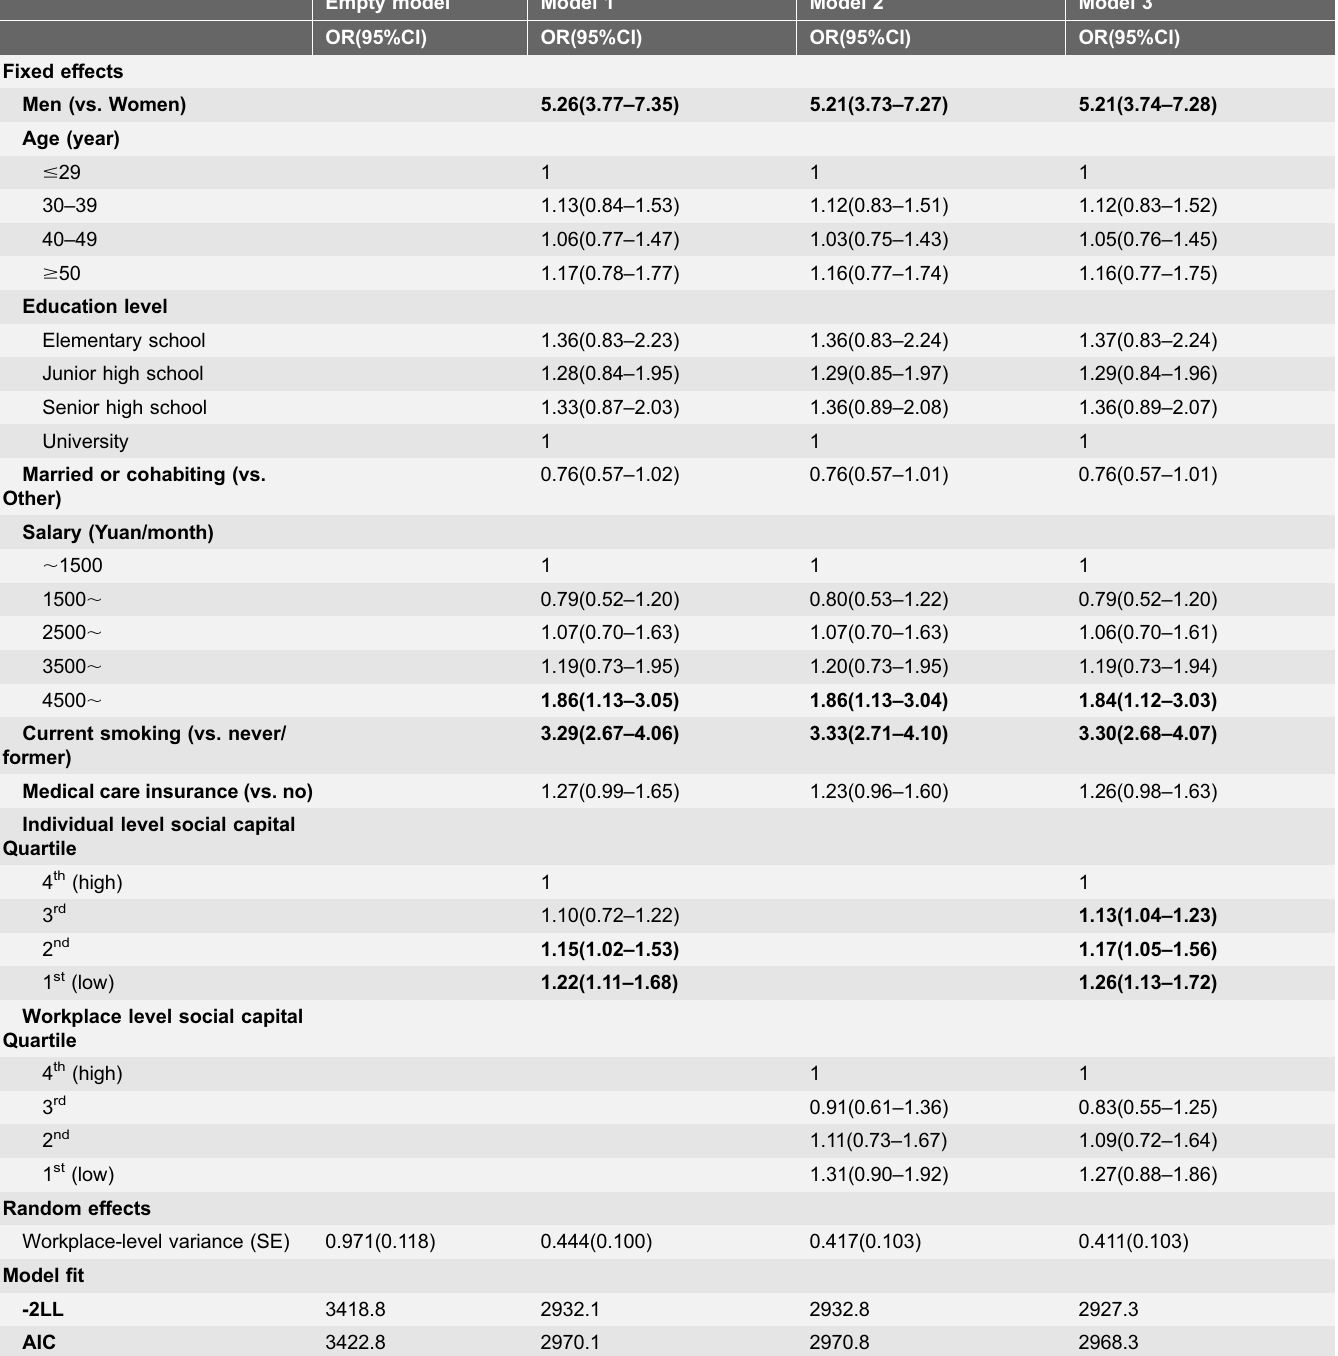
Table 2. The odds ratios and 95% credible intervals for hazardous drinking associated individual-level and workplace-level social